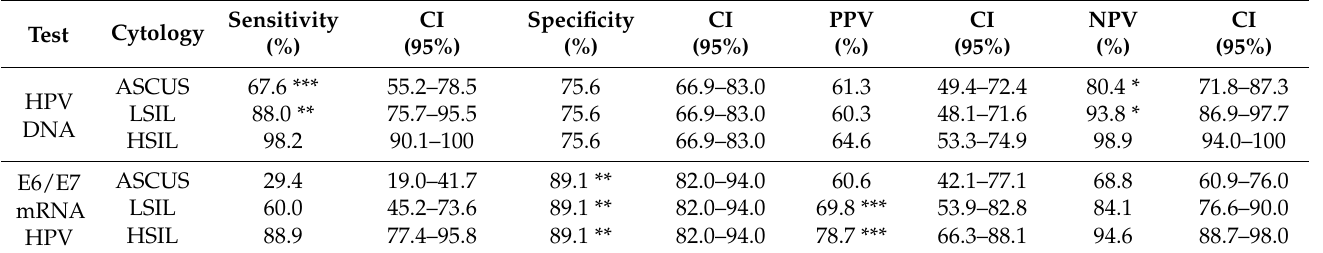
Table 10. Clinical characteristics of HR HPV DNA and E6/E7 mRNA HPV tests.